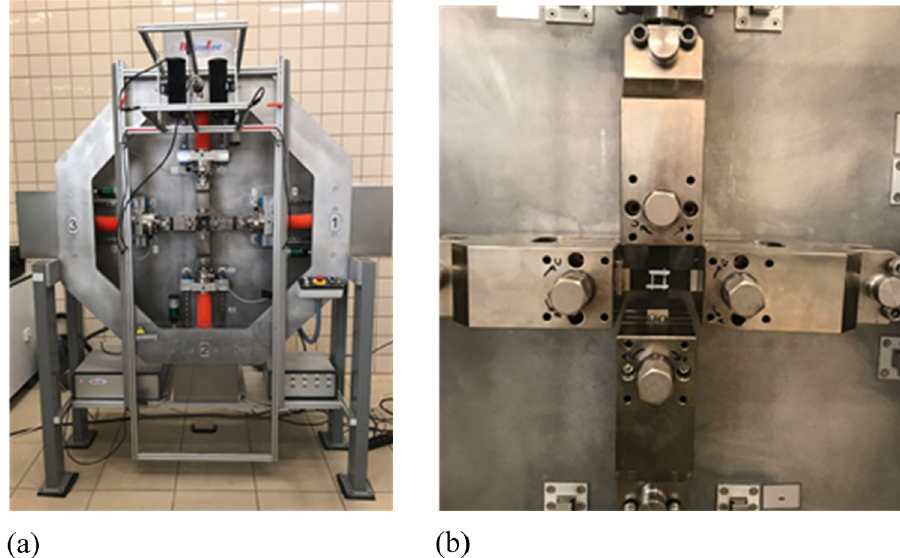
Figure 4: Biaxial testing machine: ( a ) general view, ( b ) detail of the gripping